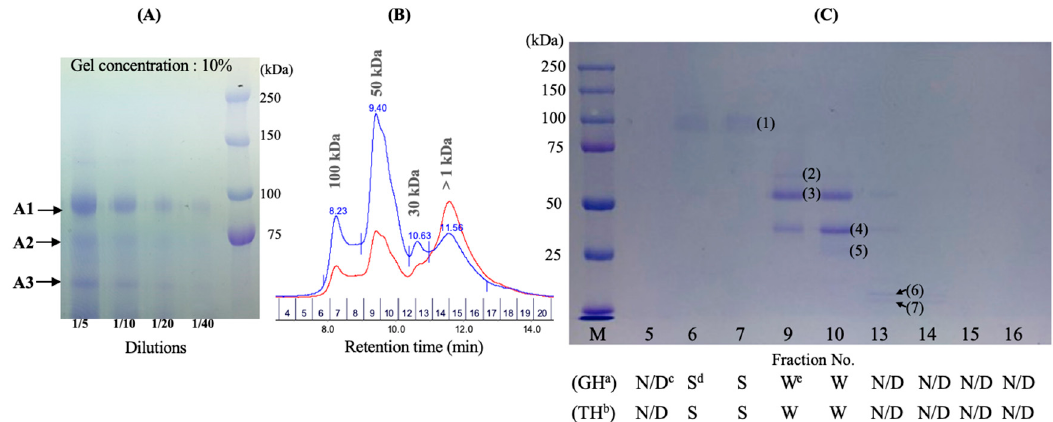
Figure 4. Sodium dodecyl sulfate–polyacrylamide gel electrophoresis (SDS-PAGE) analysis and determination of activities by the fraction of enzyme. ( A ) Size distribution of enzyme CF by SDS-PAGE. ( B ) Size exclusion chromatography of enzyme CF. Blue and red chromatograms were detected at 280 nm and 245 nm, respectively. The numbers on the x-axis of chromatography indicate the fraction of the separation by 0.5 mL, ( C ) Size distribution of the fraction which was obtained by SDS-PAGE. The numbers within the parentheses in ( C ) indicate distinguished protein bands. The fraction No. of ( C ) corresponds to the number on the x-axis of ( B ). Fraction No. 11 was omitted owing to the elution method of the fast protein liquid chromatography (FPLC) system. Abbreviations mean; a GH, glycoside hydrolase; b TH, tannin acyl-hydrolase; c N / D, not detected; d S, strong activity; e W, weak